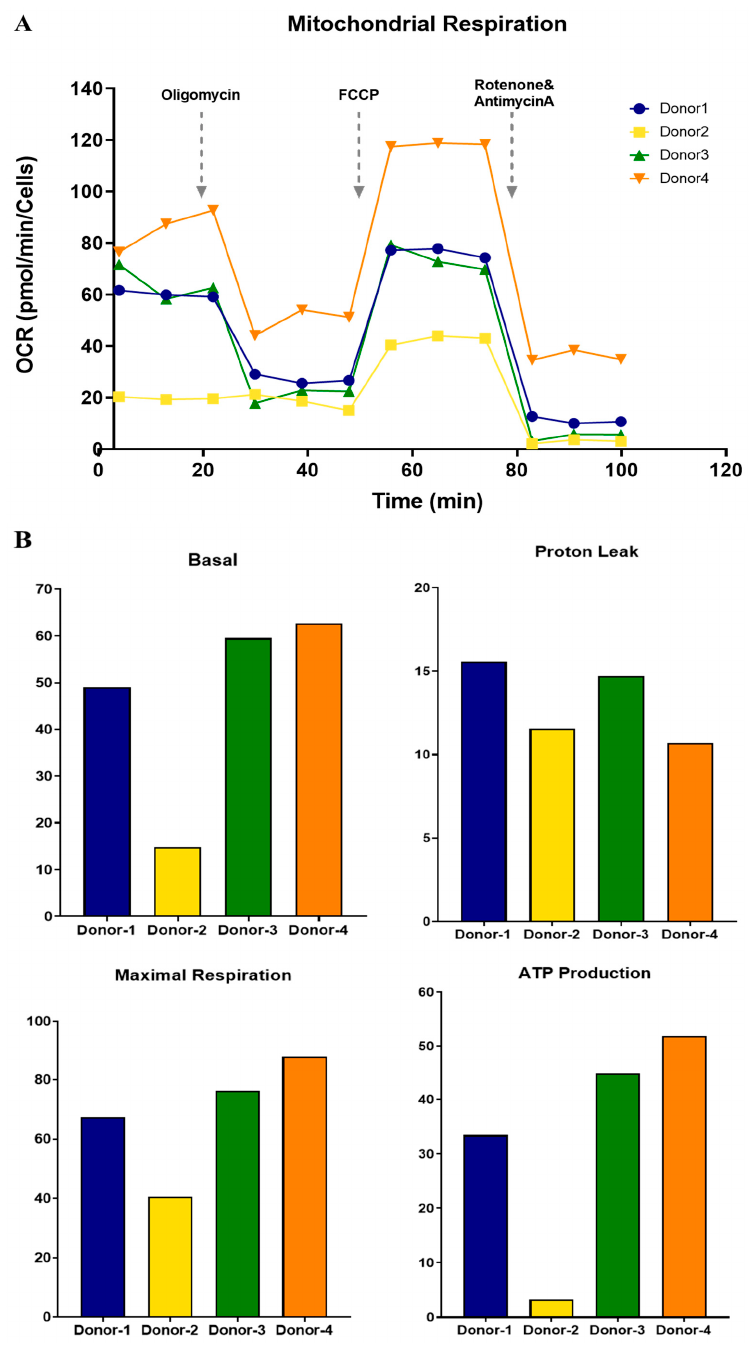
Figure 3. Mitochondrial function of islet cells isolated from partial pancreas tissue. ( A ) Observation of changes in oxygen consumption rate (OCR) during the respiration of mitochondria in isolated islet cells and ( B ) basal respiration, proton leak, maximal respiration, and ATP production (n = 4).